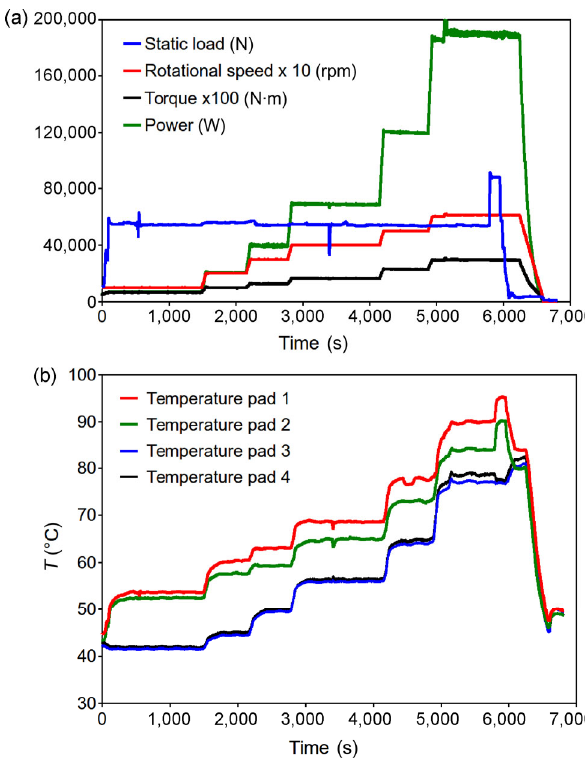
Fig. 7 Sample time trends for static load, rotational speed, torque, and power (a) and pad temperatures (b). Test with a four pad tilting pad journal bearing.